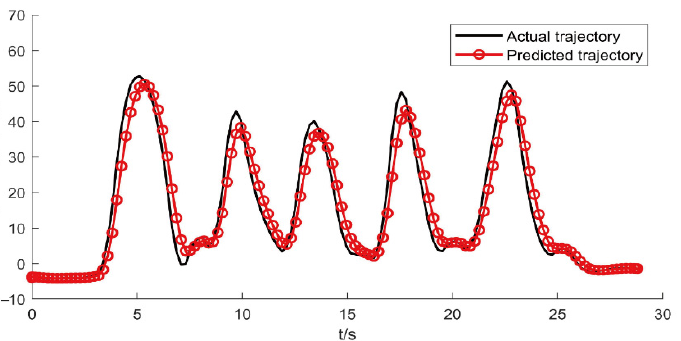
(e) The trajectory of actual measurement and predicted LSTM model at the left knee joint